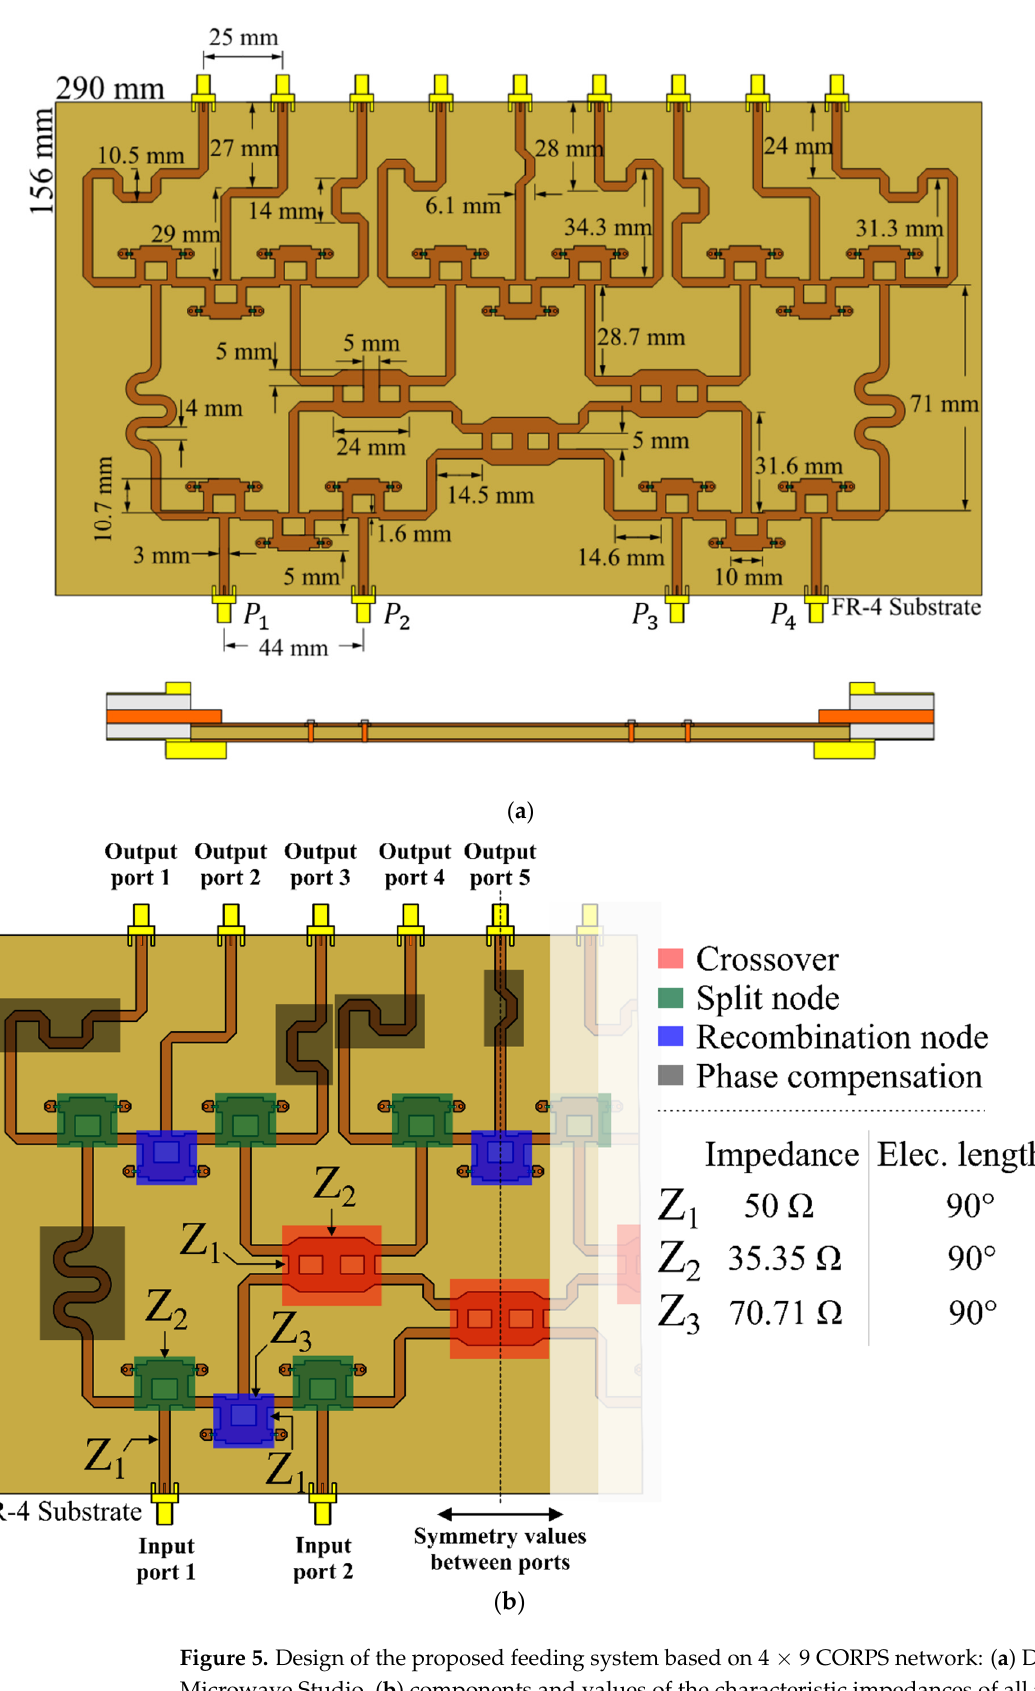
Figure 4. Scheme to illustrate the recombination nodes for the 4 × 9 CORPS network.